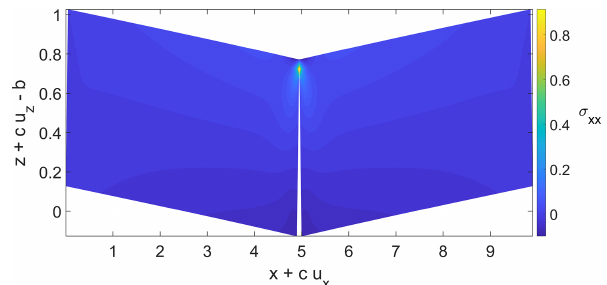
Figure 10. The extensional stress σ xx distribution for a basal crack with τ = 0 . 06 and d b = 0 . 9. We illustrate the results here using a deformed domain, plotting σ xx against a rendering of Eulerian po- sition (x + cu x ,z + cu z ) , where we use c = 0 . 02 for clarity (in re- ality, actual displacements are smaller, with c = ρ i gH/E (cid:48) = 0 . 004 for H = 500m and E (cid:48) = 1 . 1 × 10 9